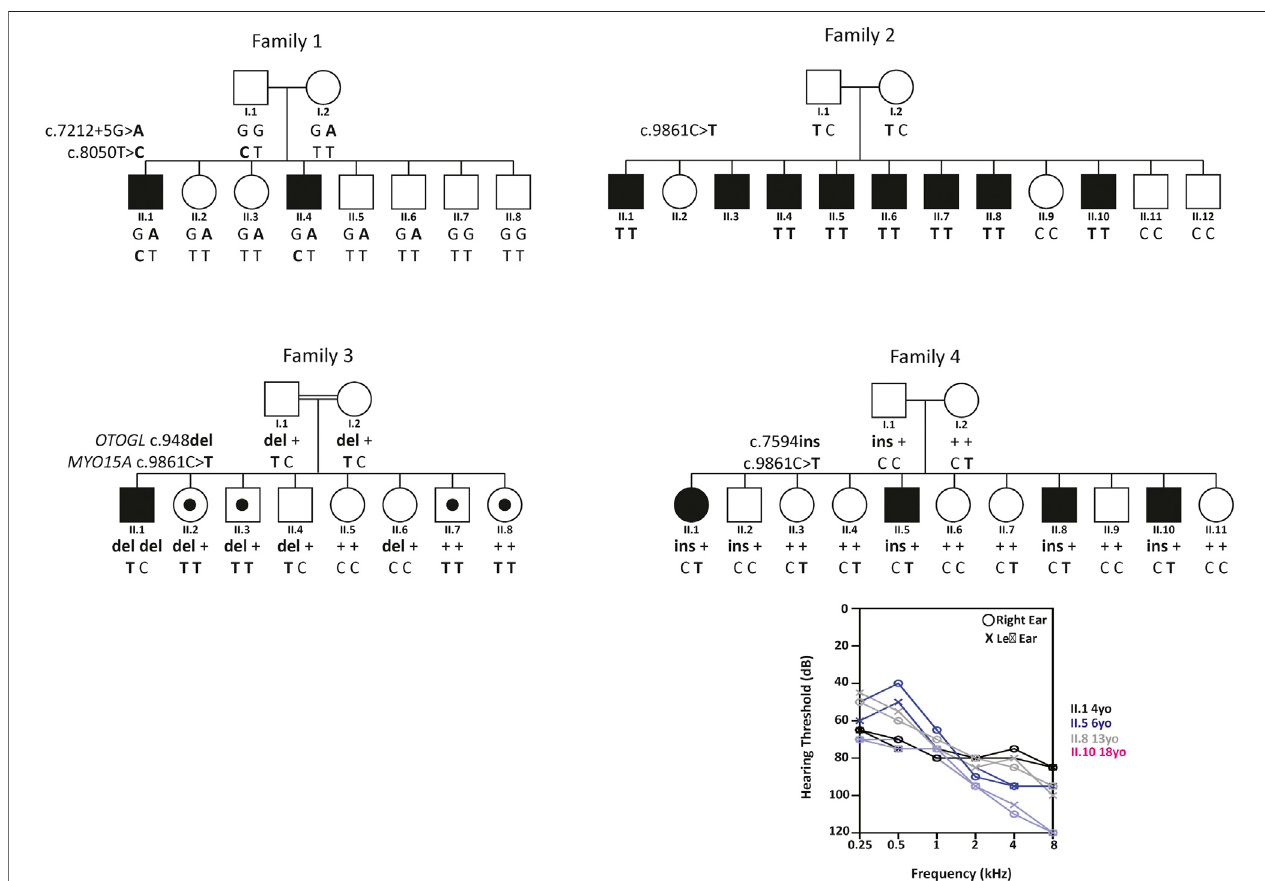
FIGURE 1 | Pedigrees, corresponding genotypes for Families 1 – 4 and audiograms. Squares and circles represent males and females, respectively. Black fi ll indicates individuals with reported hearing loss, whereas no fi ll indicates unaffected individuals. Partially fi lled symbols represent individuals that are homozygous for the deafness-causing (c.9861C > T) p.Gly3287Gly variant but are reported to have normal hearing. Consanguinity is denoted by double lines. Genotypes of participating family members are shown below each symbol with bold indicating the mutant allele. Audiograms were obtained with air conduction with the frequency range of 250 – 8,000